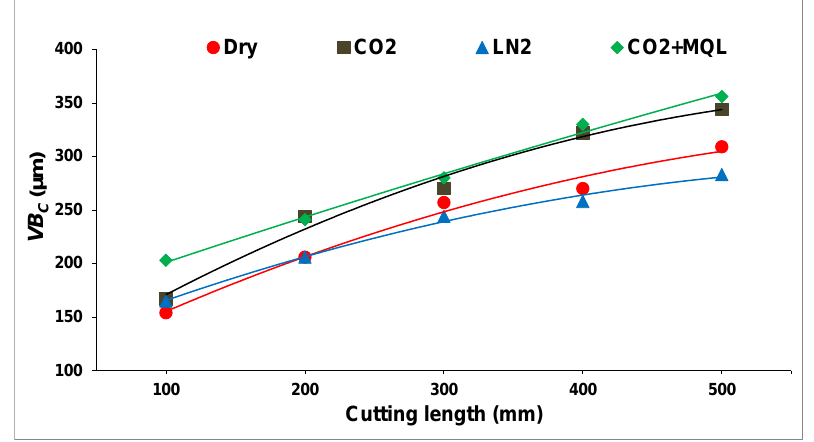
Figure 4. Progression of nose wear as a function of various machining conditions.